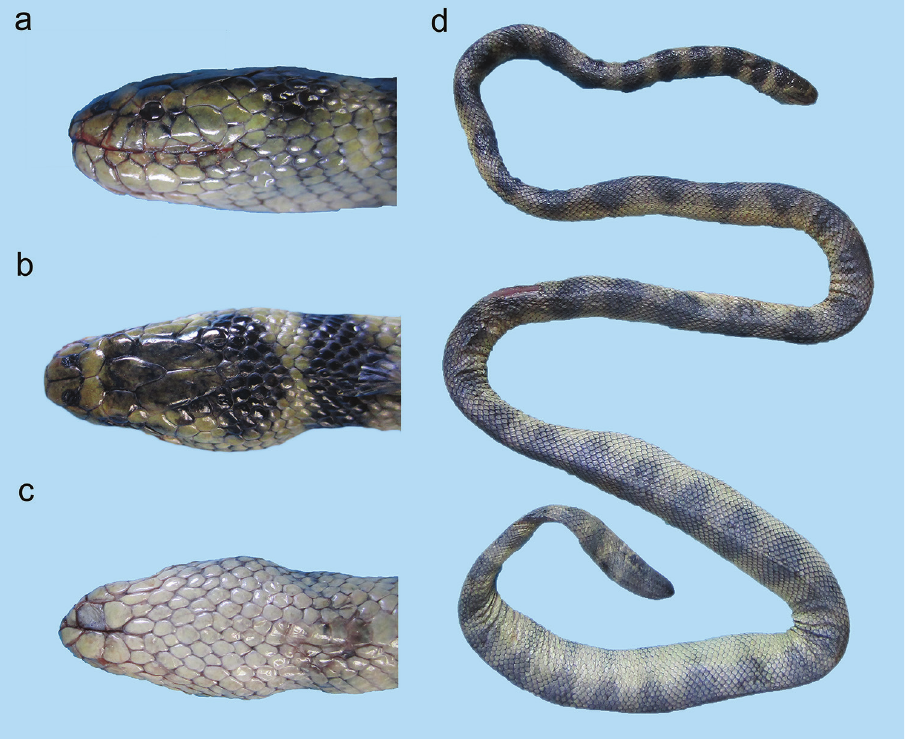
Figure 19. Hydrophis cyanocinctus : a lateral view b dorsal view, and c ventral view of head d